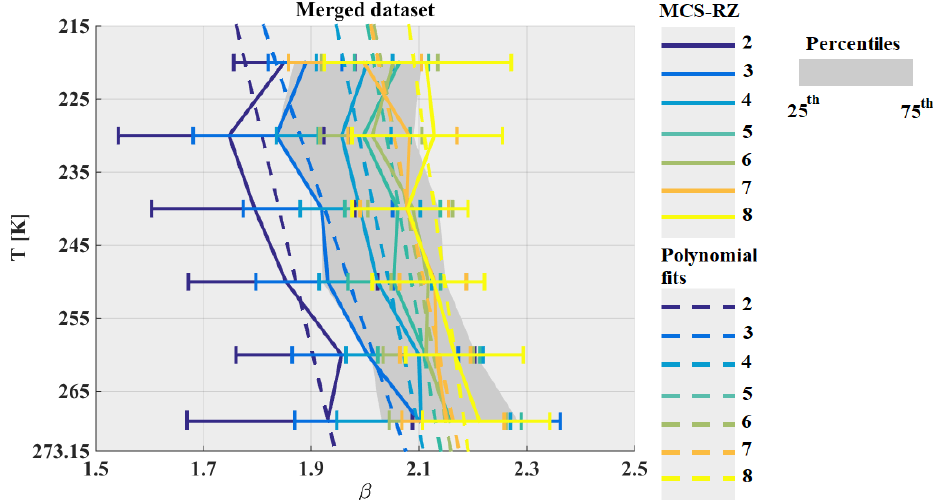
Figure 13. The same as Fig. 5 but for exponent β of mass–size relationships for the used ice hydrometeor size definition D max .